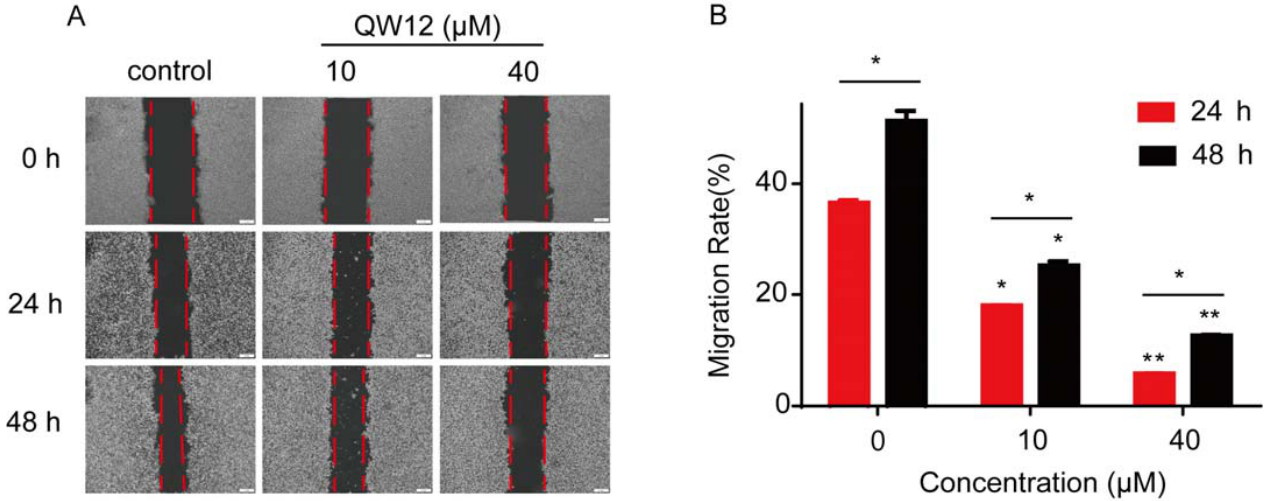
Figure 3. QW12 inhibited the migration of HeLa cells. ( A ) Effect of QW12 on the wound-healing of HeLa cells. ( B ) Quantitative analysis of scratch closure changes. Values are presented in means ± SD of three independent experiments., * p < 0.05, ** p < 0.01.